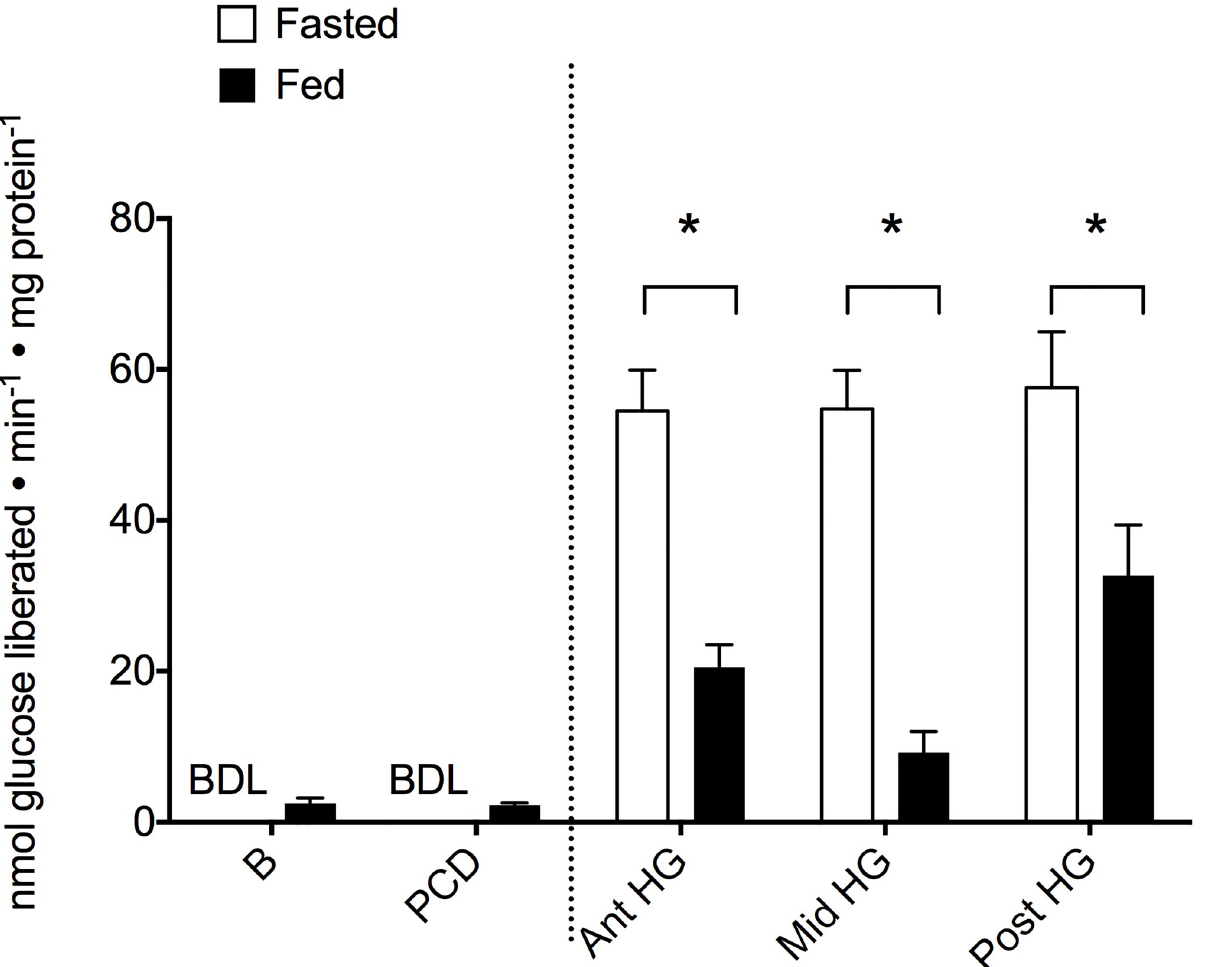
Fig 1. Changes in α - amylase activity (nmol glucose liberated min -1 mg protein -1 ) along the length of the Pacific hagfish alimentary canal and with respect to feeding status. Activity was measured in both fasted (white bars) and fed (black bars) hagfish in five locations along the alimentary canal (B—buccal cavity, PCD—pharyngocutaneous duct, Ant HG—anterior hindgut, Mid HG—mid hindgut, Post HG—posterior hindgut). Bars represent means + s.e.m. of 5–8 hagfish. A Kruskal-Wallis analysis determined that there were significant differences between the anterior and posterior segments of the tract, thus a 2-way ANOVA to determine effect of feeding and location was conducted in the hindgut only (right of the dotted line). Asterisks ( � ) denote significant differences with significance accepted at α = 0.05.